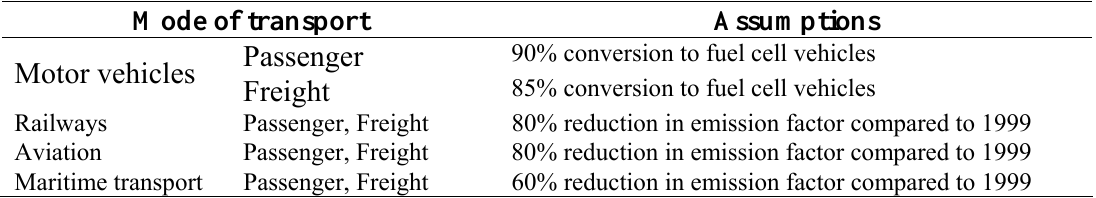
Table 8. Assumptions on technological developments in EST1 Scenario (Japan as a whole) Mode of